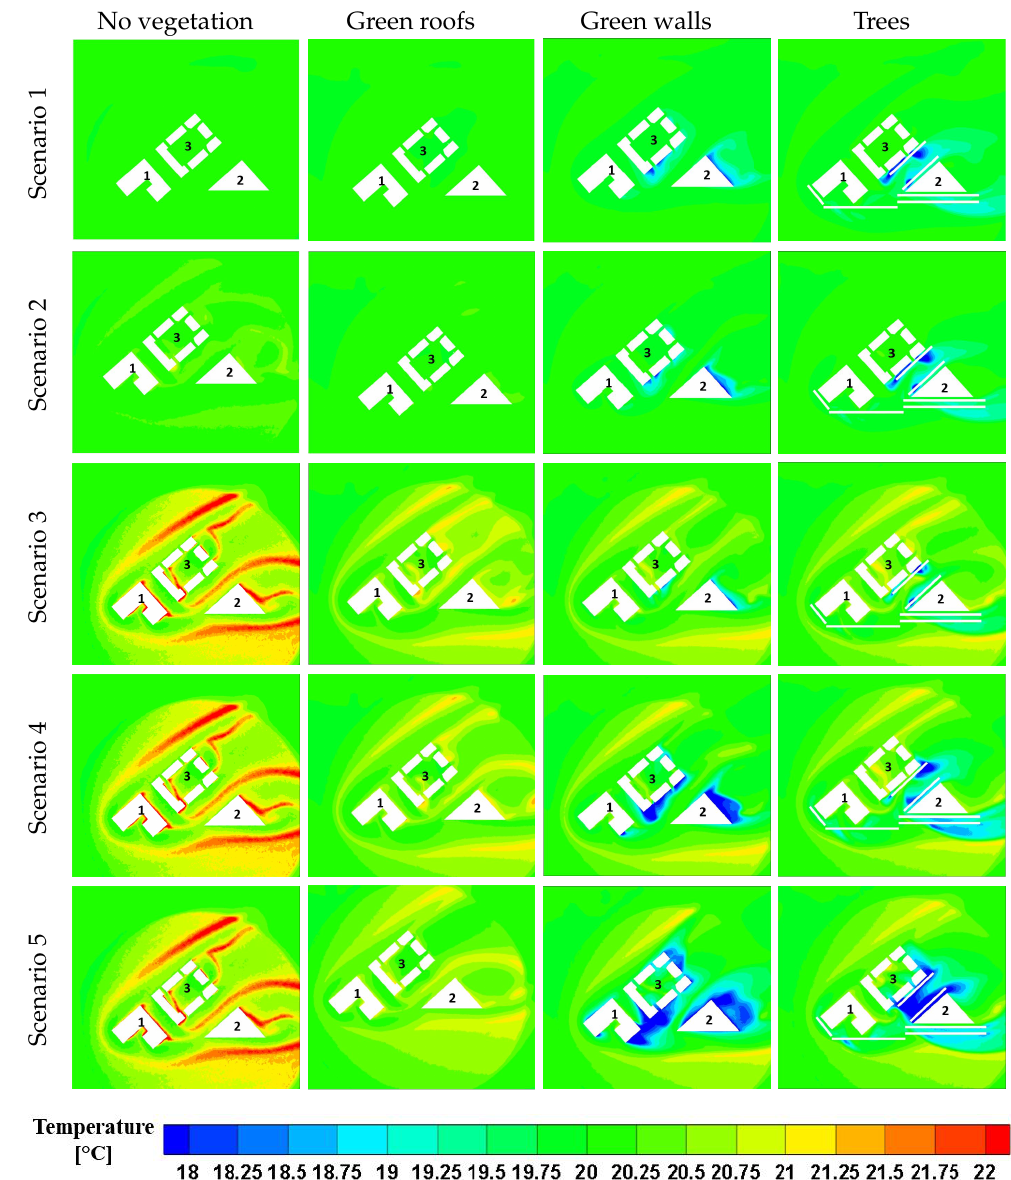
Figure 9. Contours of temperature at the pedestrian